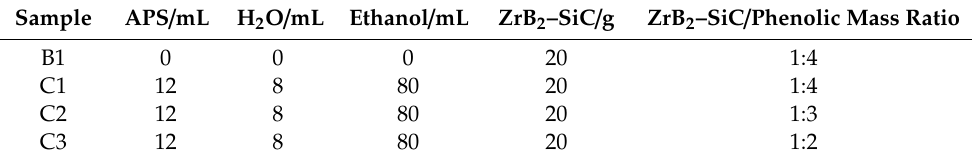
Table 1. The mass proportion of the samples.